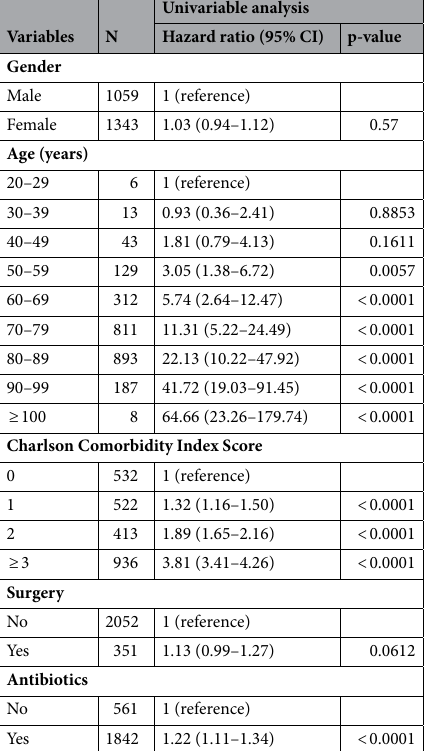
Table 5. Cox proportional hazard models of ninety-day mortality by